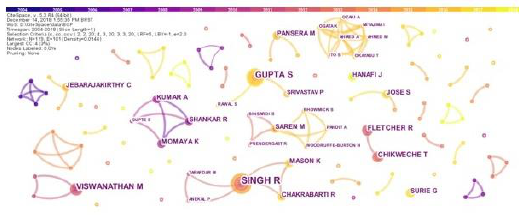
Figure 5. Network of co-authorship of the articles in the search (frequency >= 2) the articles “An exploratory investigation of aspirational consumption at the bottom of the pyramid” and “Despite unethical retail store practices, consumers at the